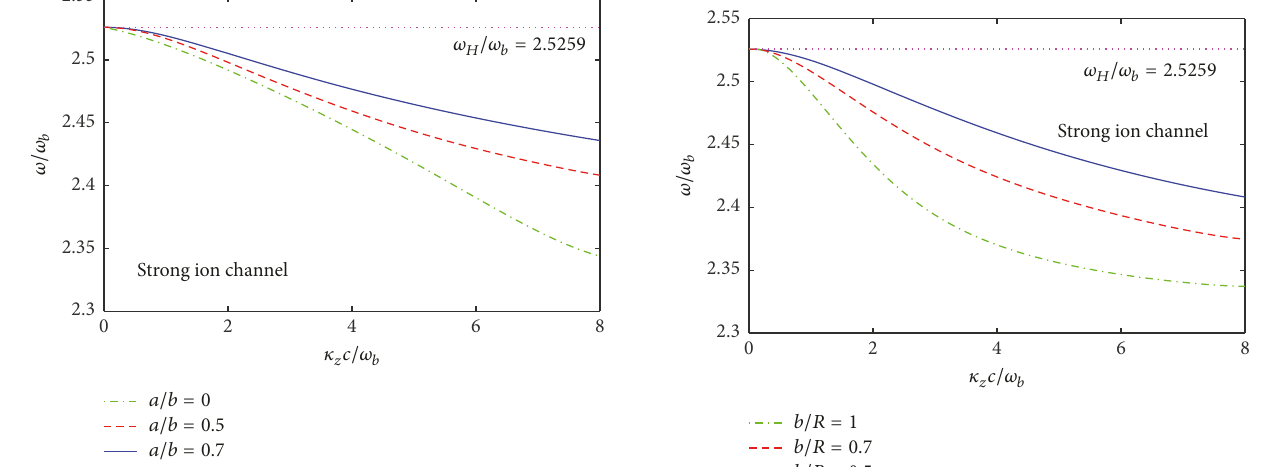
Figure 5: The influence of the ratio 𝑏/𝑅 on the dispersion curves of the Be 01 waves for strong ion channel with 𝜔 𝛽 = 2.3195 . The inner radius of the annular beam is taken as 0.25 R . 𝑏/𝑅 = 1 represents the waveguide completely filled with the annular